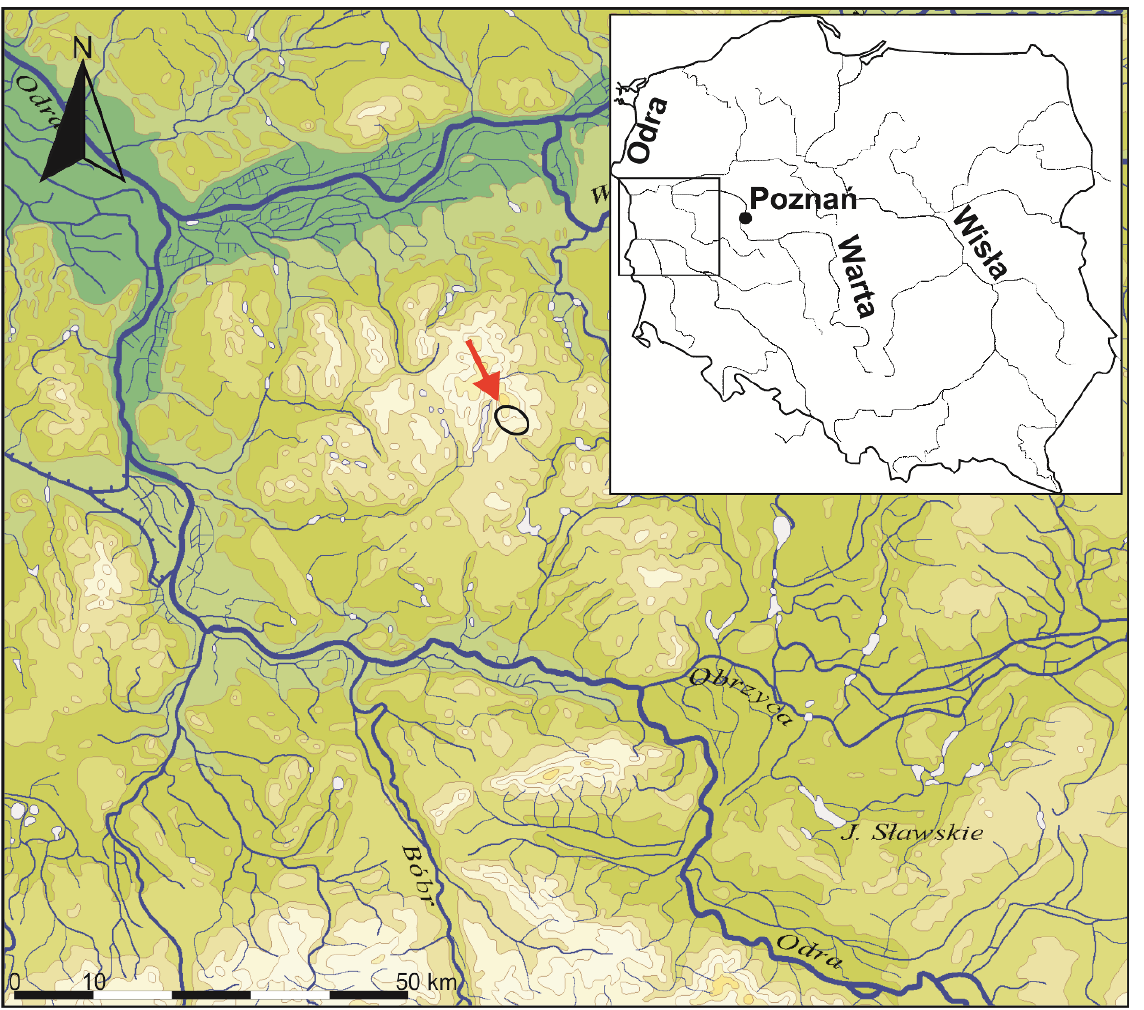
Figure 1. Concentration of the Late Palaeolithic and Mesolithic sites in Lubrza (black